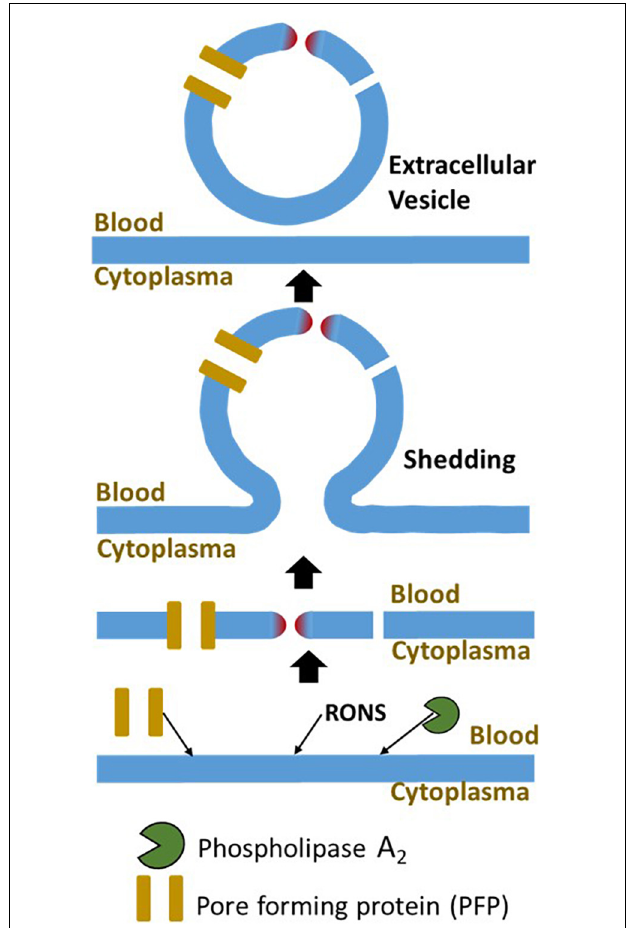
FIGURE 3 | The major mechanisms of damage to plasma membrane and its repair. The plasma membrane is damaged by three major mechanisms, interaction with PFP, lipid peroxidation, and elevated phospholipase activity. The major mechanism repairing of this damage is membrane shedding. The damaged part of the plasma membrane will be excluded from the cell in form of an extracellular vesicle. RONS, reactive oxygen and nitrogen